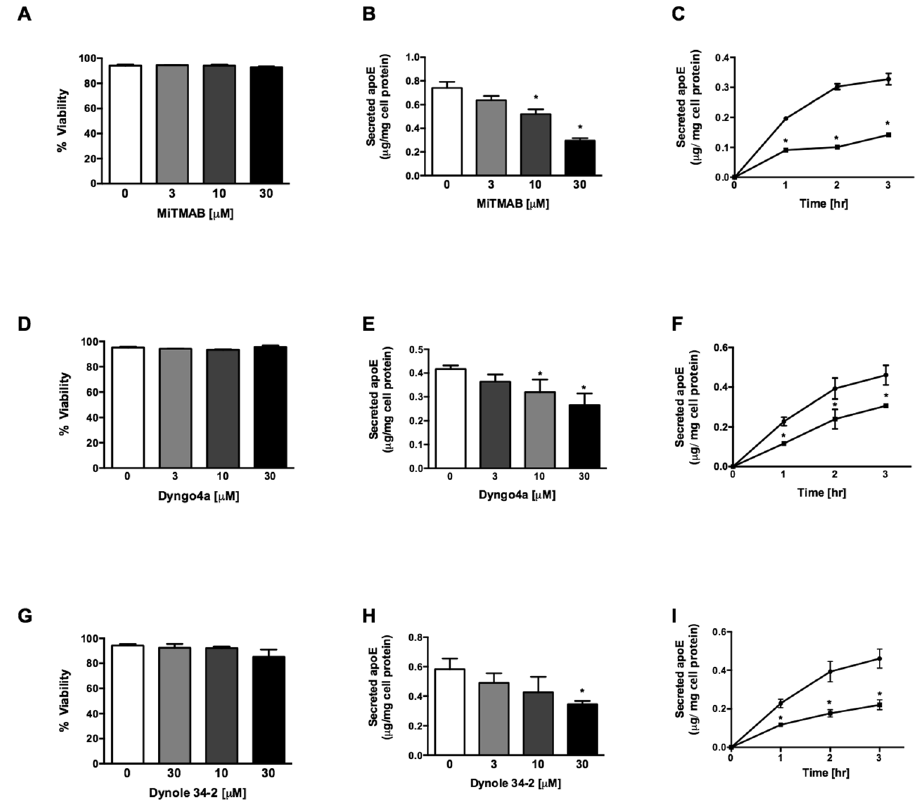
Figure 1. Dynamin inhibition decreases apoE secretion from primary human macrophages. HMDM were incubated with indicated concentrations for 3 h (A and B) and for indicated time periods at 30 m M (C) with a representative compound for each class of dynamin inhibitor. MiTMAB (A–C), Dyngo-4a (E–F) and Dynole-34-2 (G–I). Cell viability and secreted apoE were measured by LDH assay and ELISA, respectively. ( and ( & ) Treated. Data shown are mean 6 SD from triplicate cultures representative of at least 3 individual donors. * P , 0.05 v